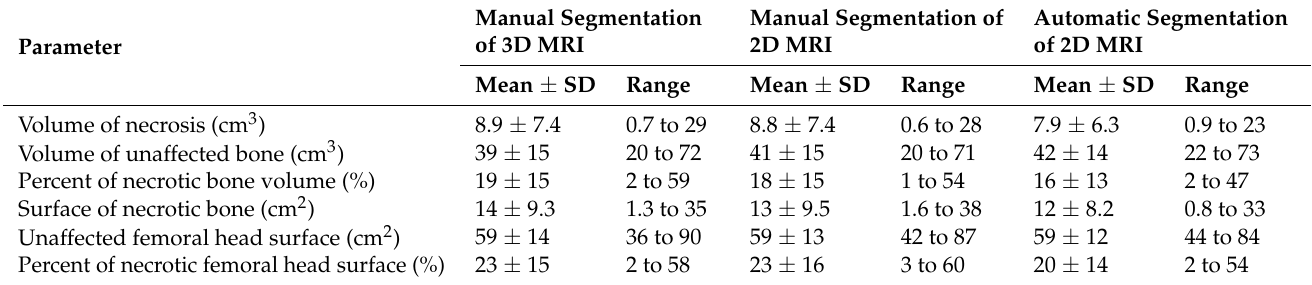
Table 2. Quantification of femoral head necrosis based on manual segmentations of 3D and 2D MRI and the automatic segmentation of 2D MRI using deep learning.